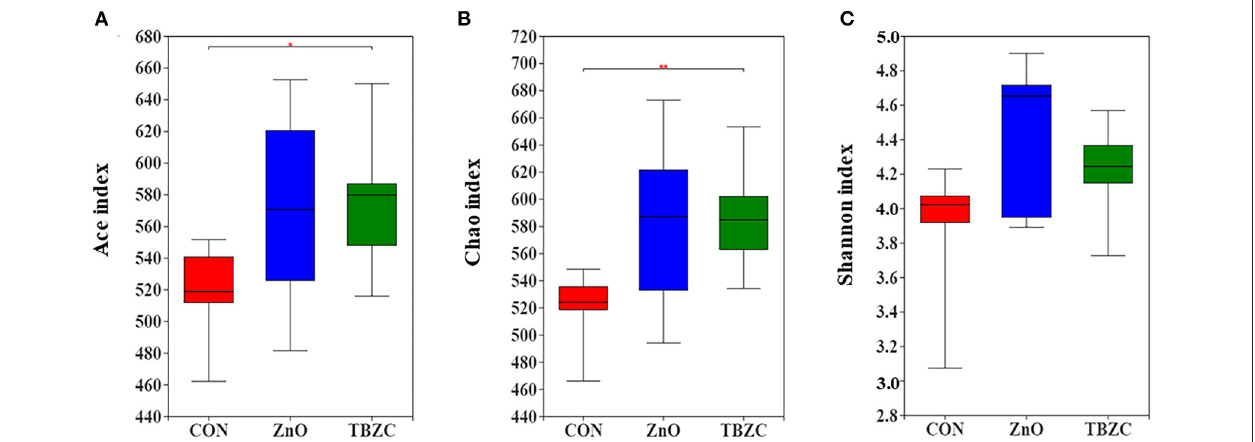
FIGURE 1 | Microbial α -diversity in the fresh fecal samples of piglets. Ace (A) , Chao (B), and Shannon (C) indices of the microbial community in different treatment groups. Data are the means of the indexes within each treatment ( n = 6). CON, a control diet without any Zn source addition; ZnO, CON + 1,600mg Zn/kg from zinc oxide; TBZC, CON + 1,000mg Zn/kg from tetrabasic zinc chloride. *Represents 0.05 < p < 0.01, **represents p < 0.01.